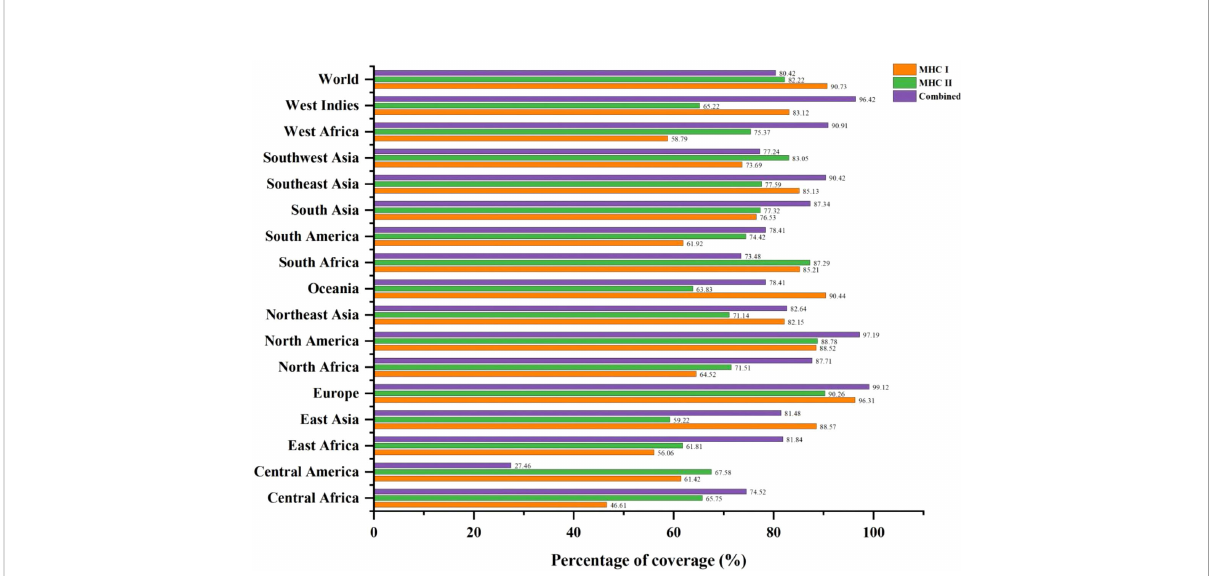
FIGURE 2 Global population coverage of selected T-cell epitopes (MHC-I, MHC-II, and combined MHC) based on their corresponding HLA binding